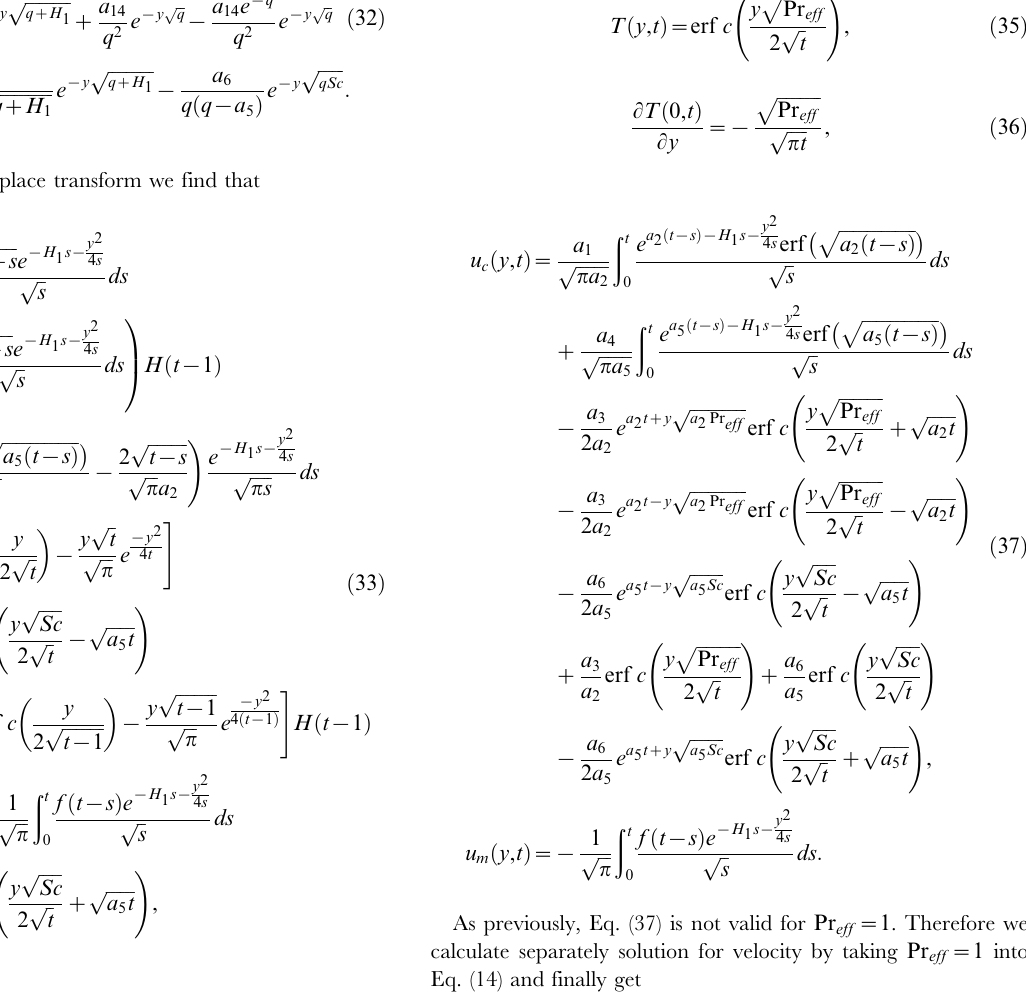
ffiffiffiffiffiffiffiffiffiffiffiffiffiffi t { s ð